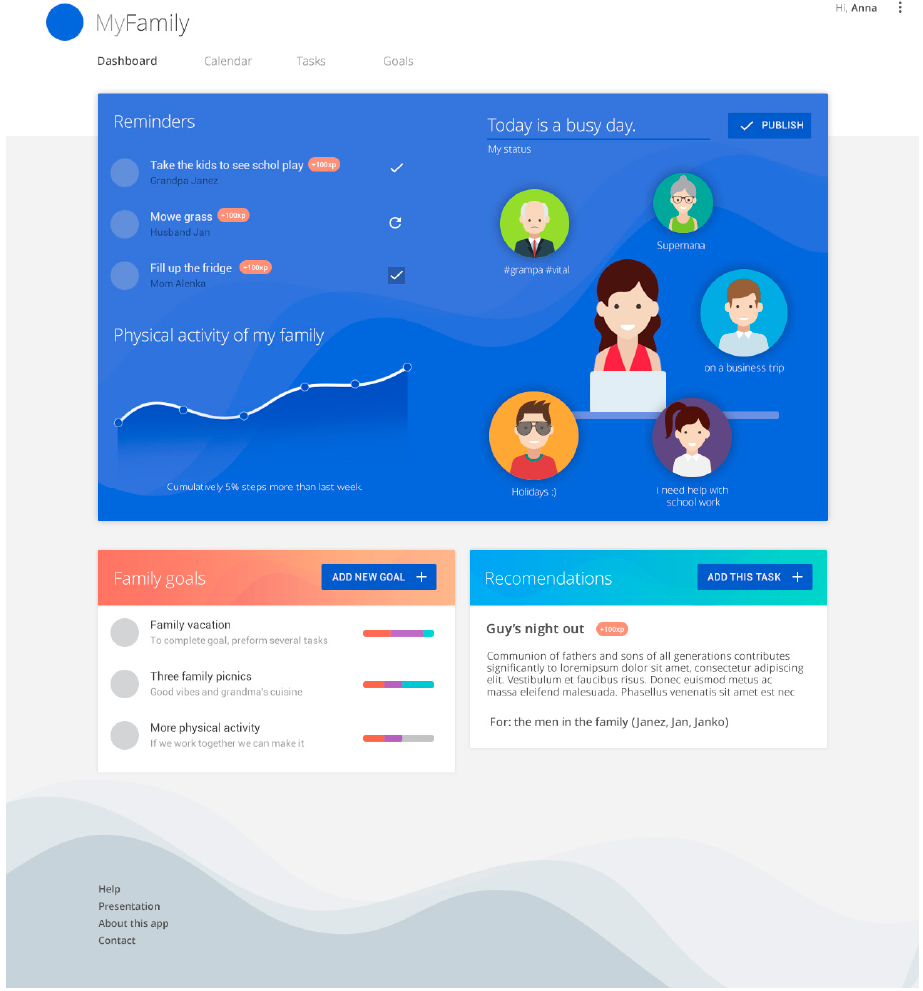
Figure A1. User interface of an interactive prototype solution translated into English.